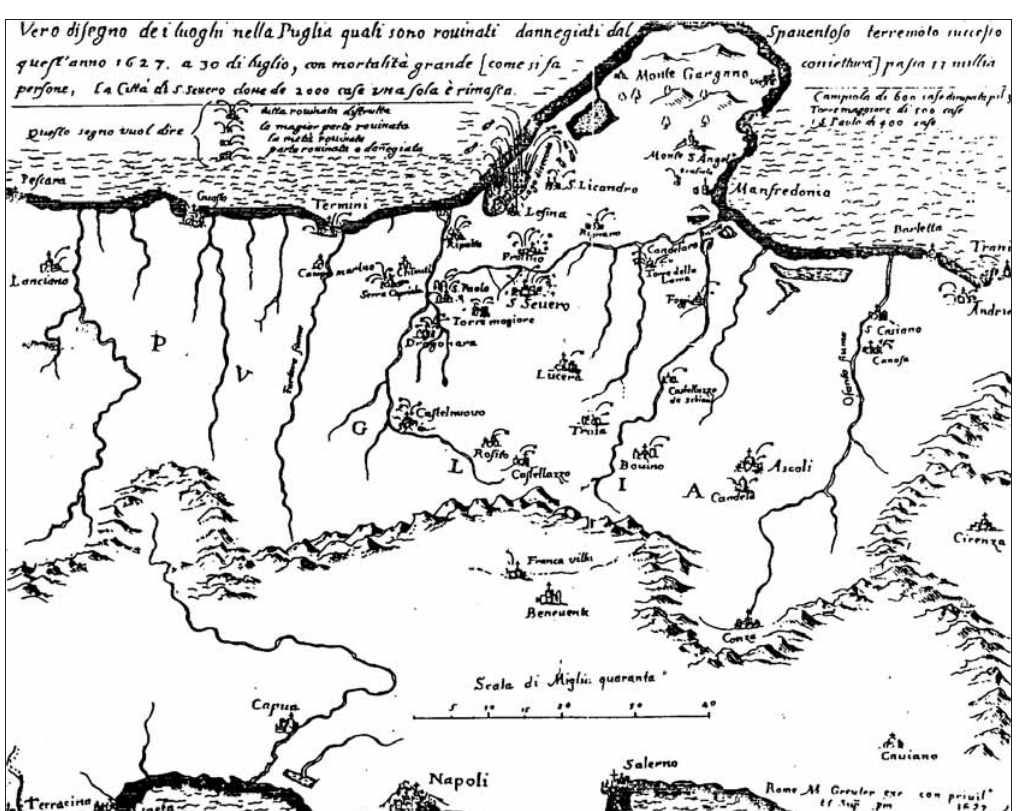
Fig. 3. Drawing from De Poardi (1627) describing some effects of the 1627. Note that fishes are drown as the rows out from the Lesina Lake. This map can be considered as the ancestor of modern macroseismic maps, since the author represented with various symbols cities which sustained different levels of